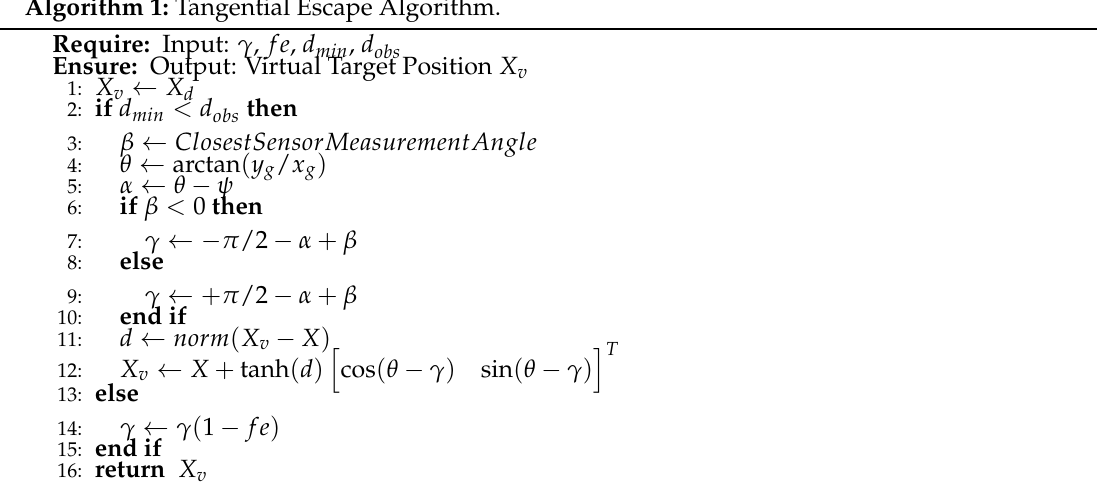
Algorithm 1: Tangential Escape